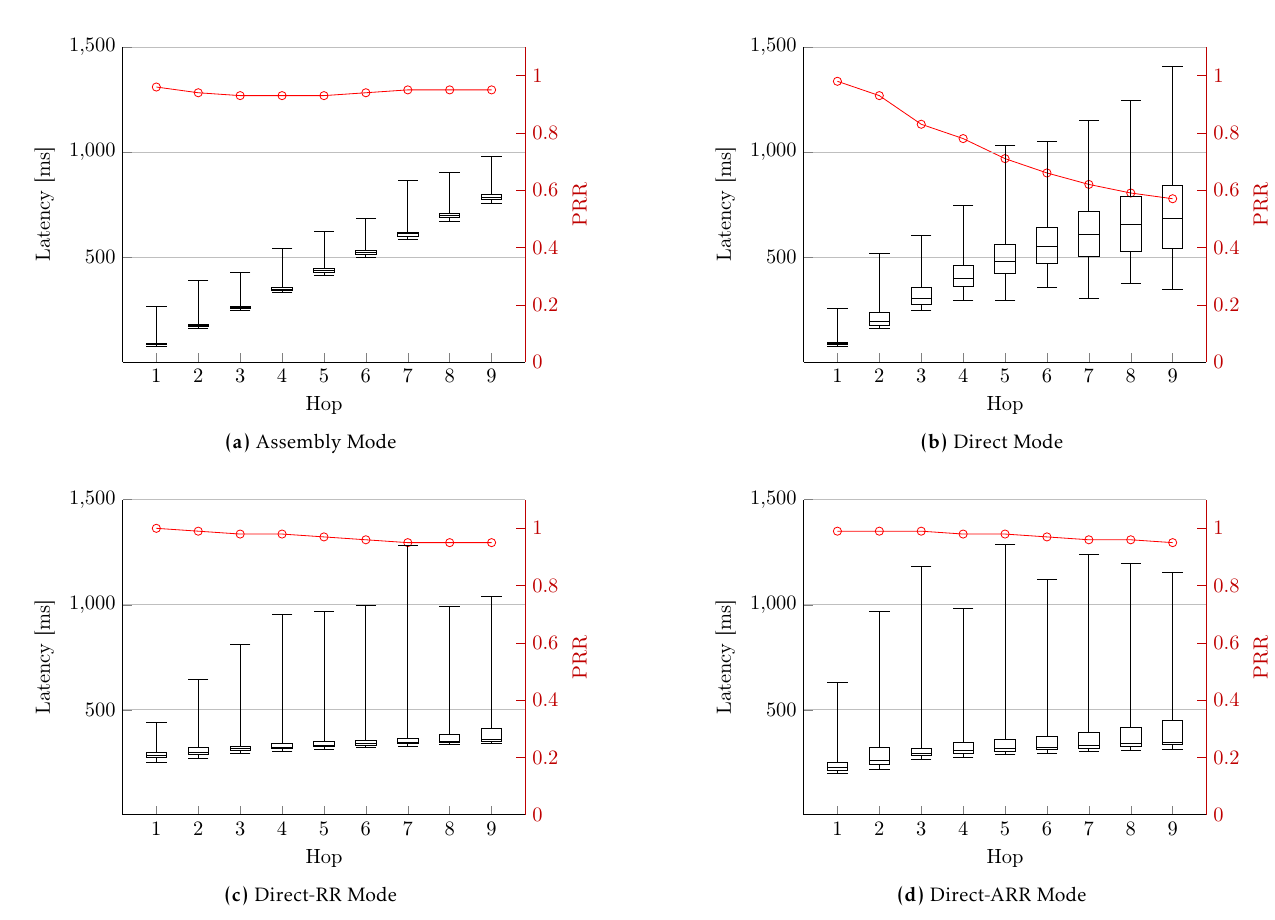
Figure 4. Per hop latency and PRR in the Chain Network with 37 . 5 B/s and 1200 bytes payload; first set of experiments